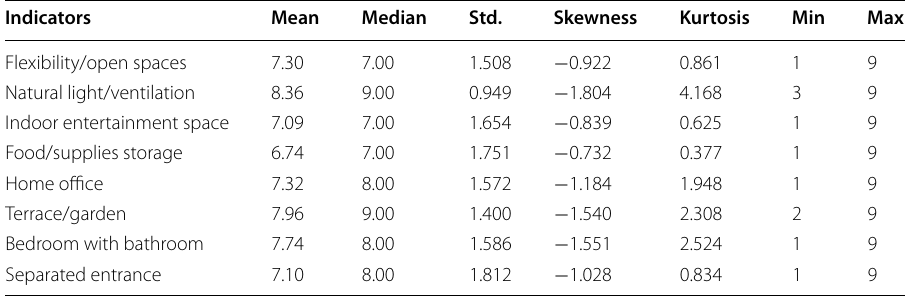
Table 5 Descriptive